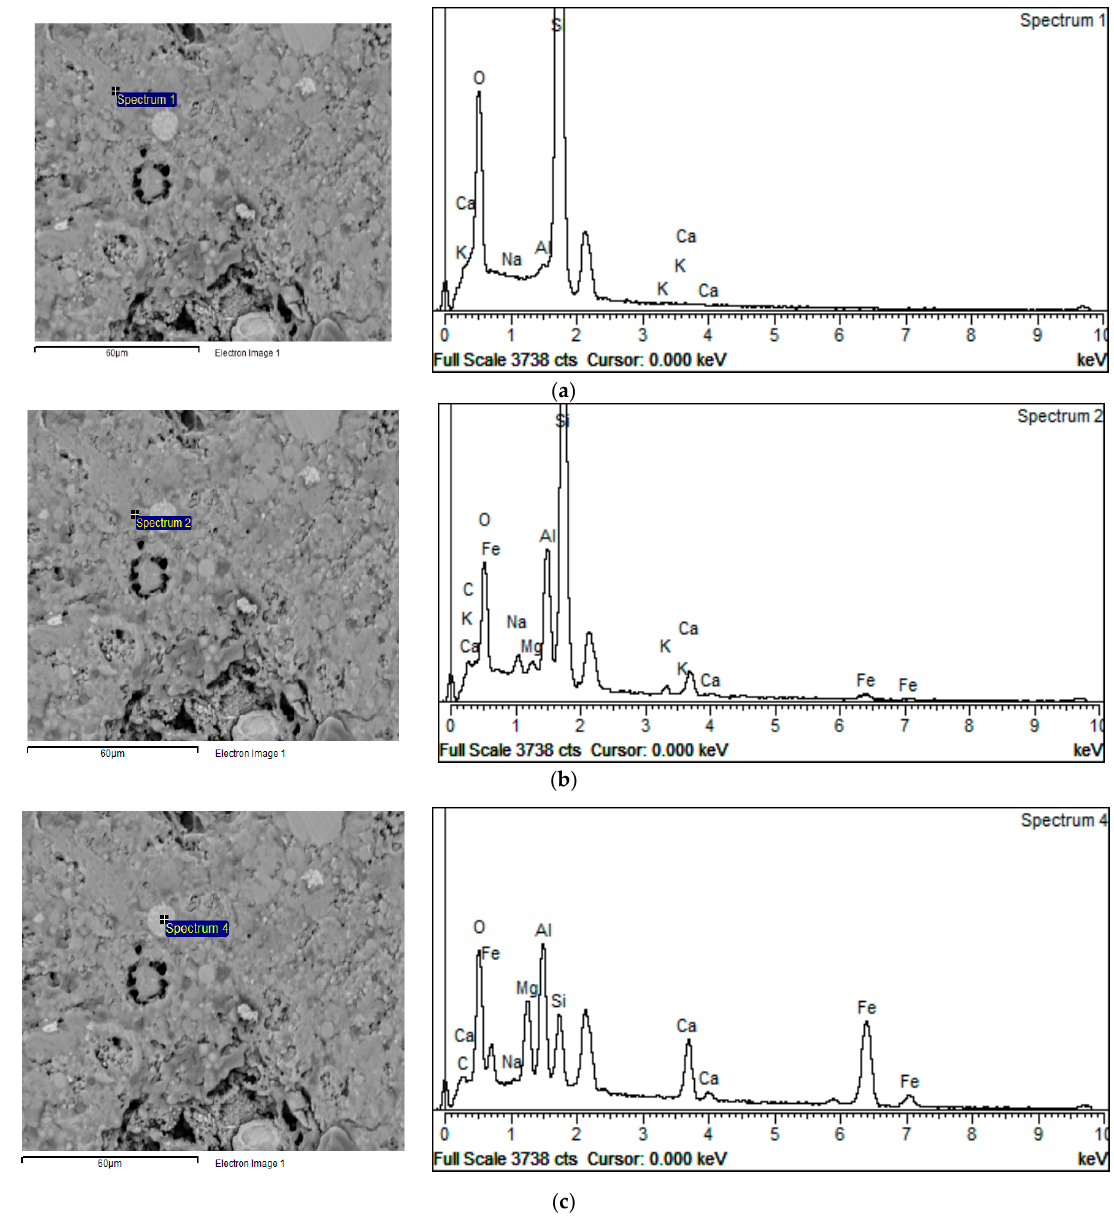
Figure 6. BSE micrograph of sample VC 120, ( a ) silica phase, ( b ) alumino ‐ silicate phase, ( c ) predominantly aluminum